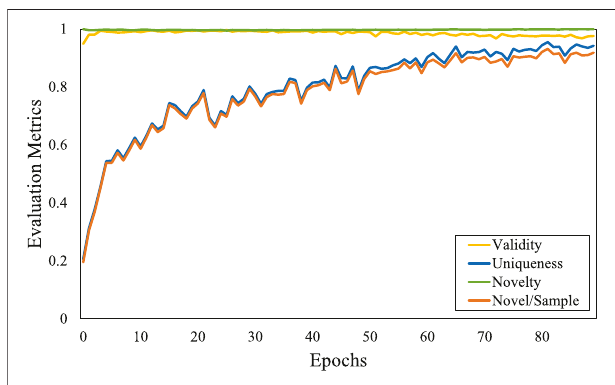
FIGURE 4 | Convergence of the four evaluation metrics with the ZINC dataset.